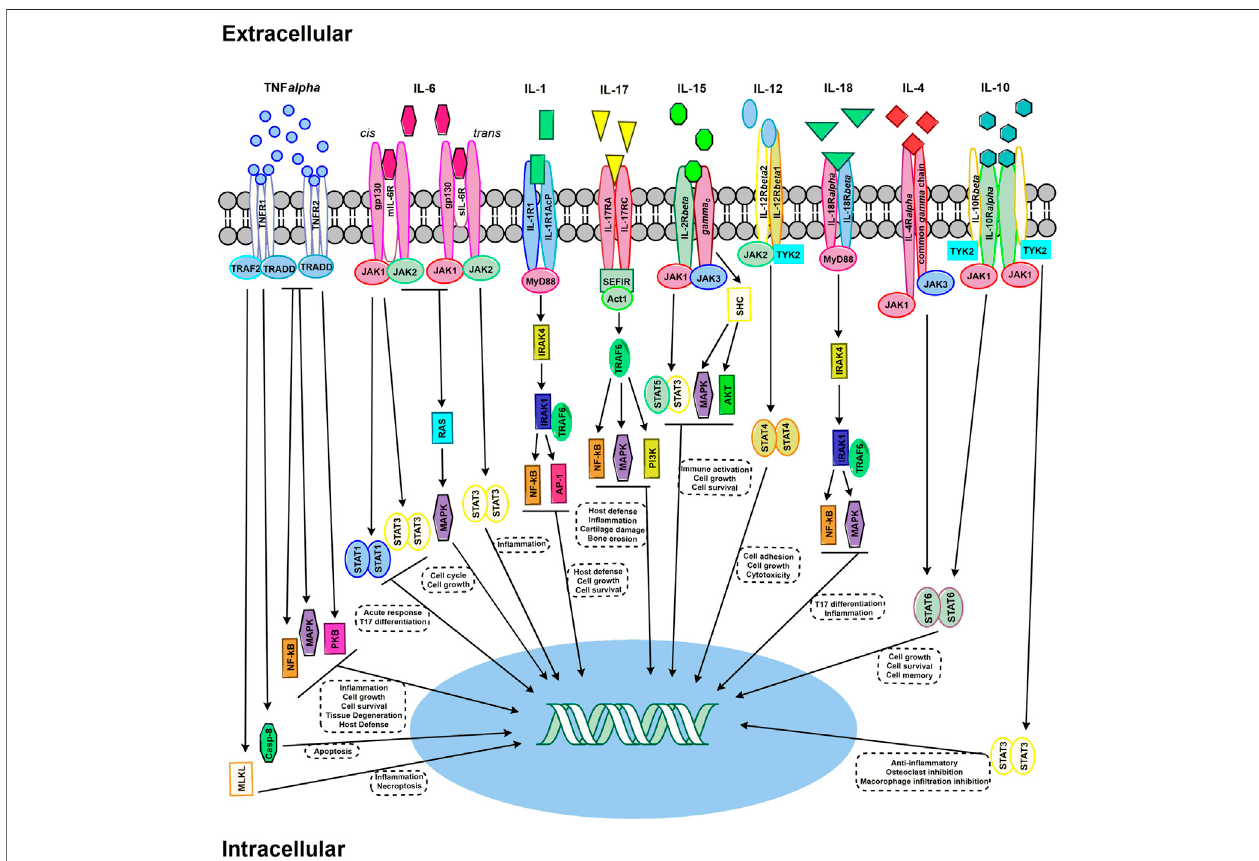
FIGURE 4 | Select signaling pathways in RA. TNF- α signaling pathways required either TNFR1 or TNFR2 trimers. Signaling via TNFR1 pathway, upon TRADD bindingwithoutTNFR2,triggerscelldeathbyeitherCasp-8orMLKL.TherecruitingofTRAF2activatesmultiplesignalingpathwaycascadeactivation – includingMAPK, NF-kB,andPKB.IL-6signalingcanoccurthrougheithermIL-6RclassicsignalingandofsIL-6Rtranssignaling.JAKactivationoccursthroughbothsignalingmechanism and activating STAT and RAS/MAPK. IL-1 signaling through IL-1R1 via MyD88 which activates IRAK4 and subsequently IRAK1 bound to TRAF6 – leading to the activation of NFkB and AP1. IL-17 binds to an IL-17RA and IL-17RC receptor dimer. The SEFIR conserved signaling domain recruits Act1, which recruits TRAF6 and subsequently activates NF-kB, MAPK, and PI3K signaling pathways. IL-15 signaling can occur through JAK/STAT activation resulting in STAT3/STAT5 heterodimer formation, or activation through SHC which then results in activating MAPK and AKT. IL-12 signaling occurs through a heterodimer receptor consisting ofIL-12R β 1 and IL-12R β 2 which activates JAK2 and TRK2 – leading to STAT4 dimer activation. IL-18 signaling results from the recruiting of MdD88 to the IL-18R α and IL-18R β heterodimer, activating IRAK4 and thus TRAF6, which subsequently activates NF-kB and MAPK pathways.IL-4 signaling occursthe JAK/STAT activationvia JAK1and JAK3 binding to the IL-4R α and common gamma-chain, respectively. IL-10 signal transduction results from both JAK1 binding to IL-10R α and TYK2 binding to IL-10R β – which activates STAT3 in homodimer form.